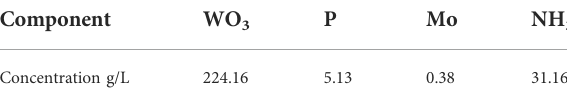
TABLE 1 Main composition of the ammonium tungstate solution.